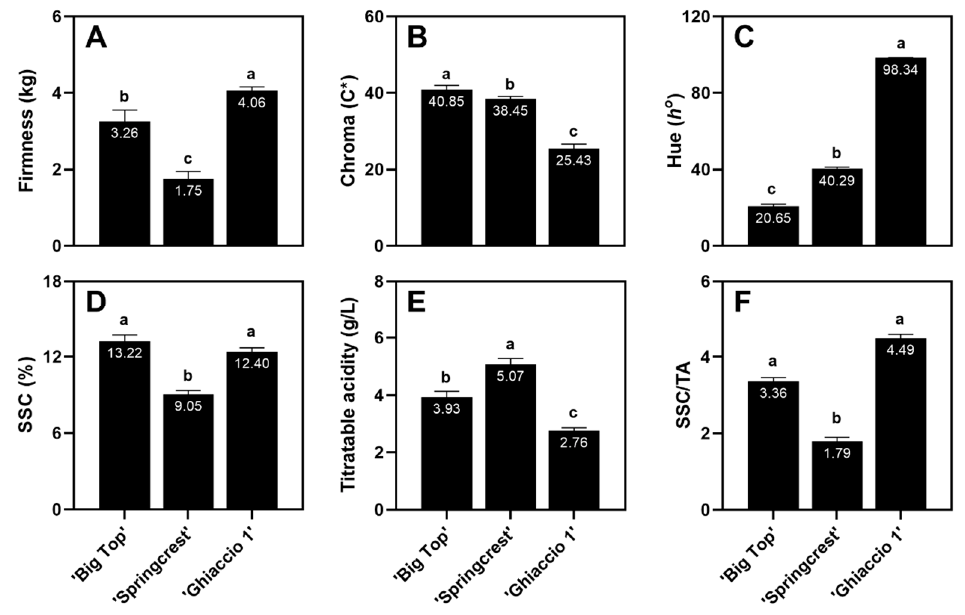
Figure 9. Quality characteristics (firmness ( A ), exocarp chroma ( B ), and exocarp hue angle ( C ), soluble solids concentration (SSC) ( D ), titratable acidity (TA) ( E ), and SSC/TA ratio ( F )) of the selected commercial cultivars, ‘Big Top’, ‘Springcrest’ and ‘Ghiaccio 1 ′ at harvest in 2008. Tukey (HSD) test for post-hoc mean comparisons. Columns with the same letter above indicate non-significance at p -value < 0.05. Mean comparisons evaluated for each fruit quality characteristic. Means ± S.E. displayed.